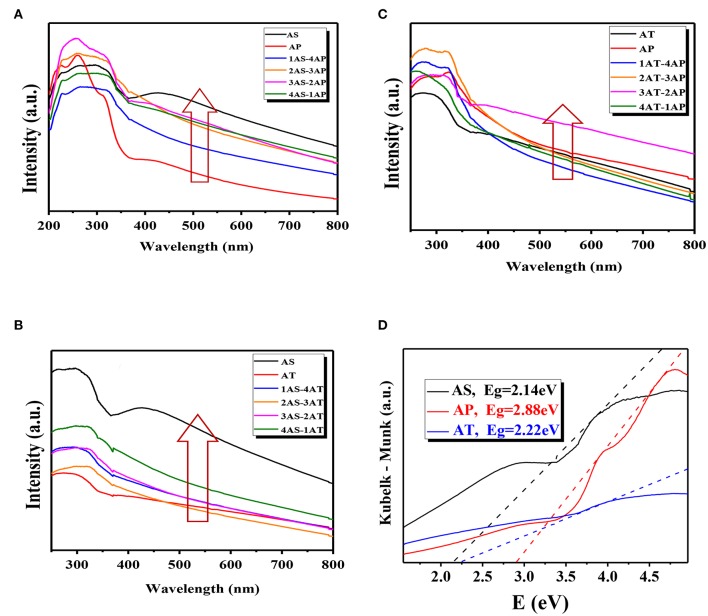
UV-vis absorption spectra (A–C) and the Kubelka–Munk diagrams (D, obtained from the data of the UV- vis absorption spectra) measured at different mixing binary component systems: (A) AS-AP, (B) AS-AT, and (C) AP-AT. AS, Ag2O-TiO2 nanosphere; AP, Ag2O-TiO2 nanoplate; AT, Ag2O-TiO2 nanotube.